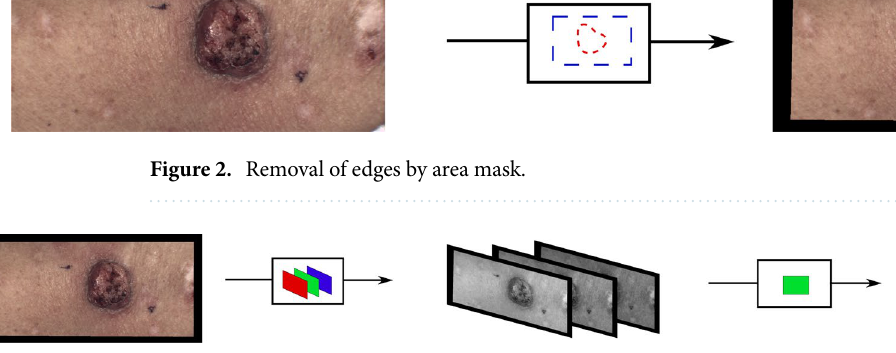
Figure 3. The green colour data were extracted from each frame of the video.